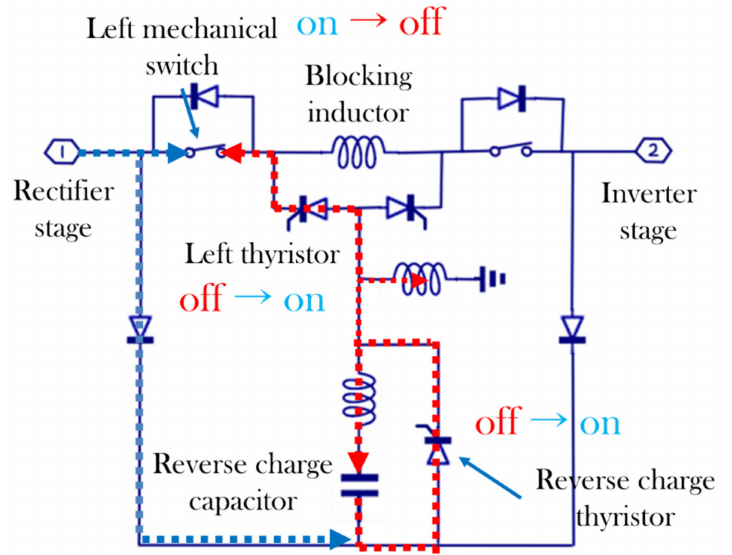
Figure 2. Current flow of LC resonant emission current and fault current from the rectifier stage to the